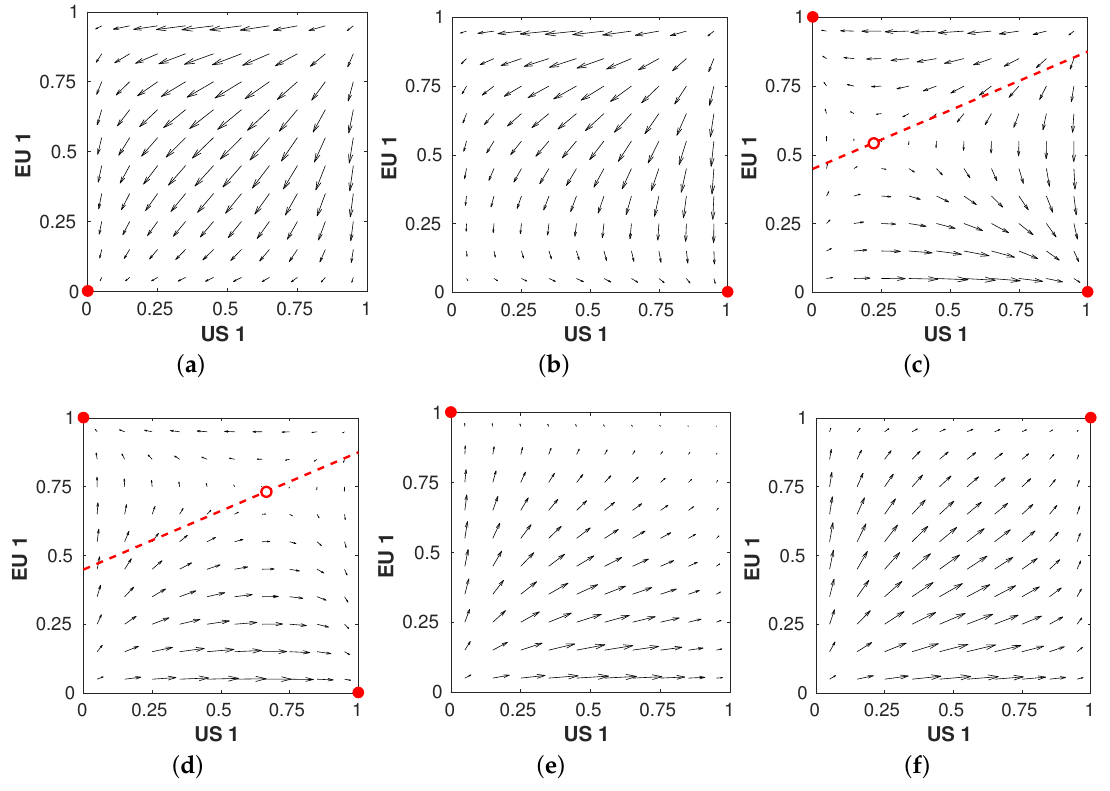
Figure 10. Evolutionary dynamics of the subgame { remove 1,remove 2 } for different values of C r . Stable attractors are indicated with and unstable attractors with . The dotted line indicates the trajectory on which the mixed equilibrium moves as C r changes. ( a ) C r = 0.0003; ( b ) C r = 0.0004; ( c ) C r = 0.00047; ( d ) C r = 0.00051; ( e ) C r = 0.00055; ( f ) C r =